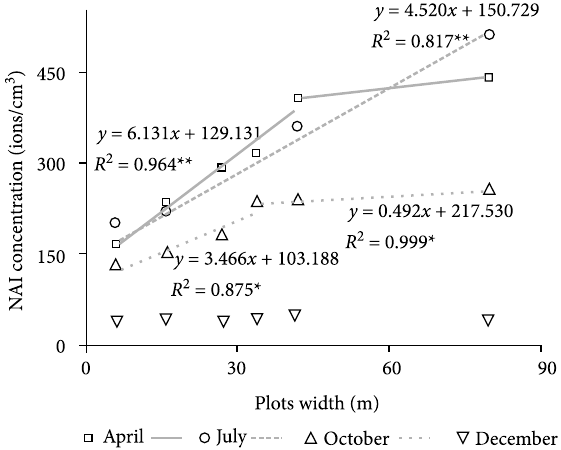
Fig. 12. Linear correlation analysis of average NAI concentrations in green